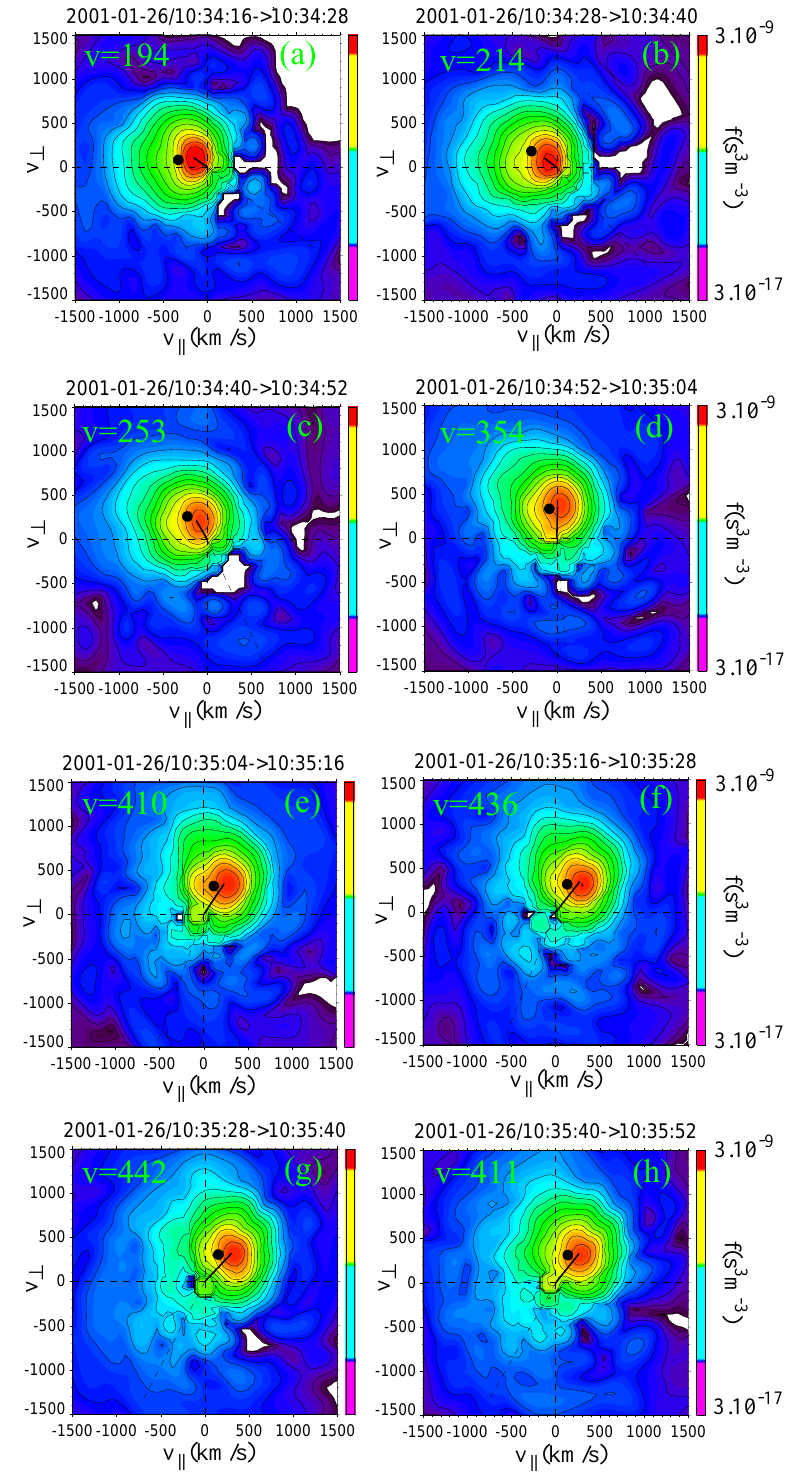
Figure 8. Two-dimensional cuts of the 3D ion distributions through velocity space that contains the directions of the magnetic field (to the right) and E × B (upward), with 12-s sampling time. The projection of the sunward direction is marked by the black dashed line. Bulk velocity is marked by the short black line. The 8 consecutive ion distributions were taken as the spacecraft moved from the magnetosheath (Panels a-c) across the MP/BL (d-h). The black dot in all panels denote the projection of the HT velocity. No D-shaped distributions are observed in this and any other reconnection jets on this pass.